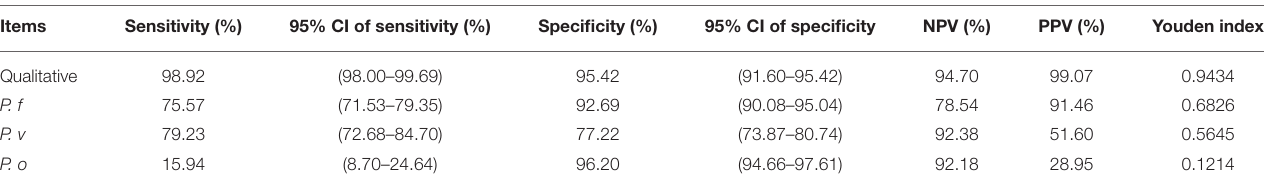
TABLE 2 | Indexes of the technicians’